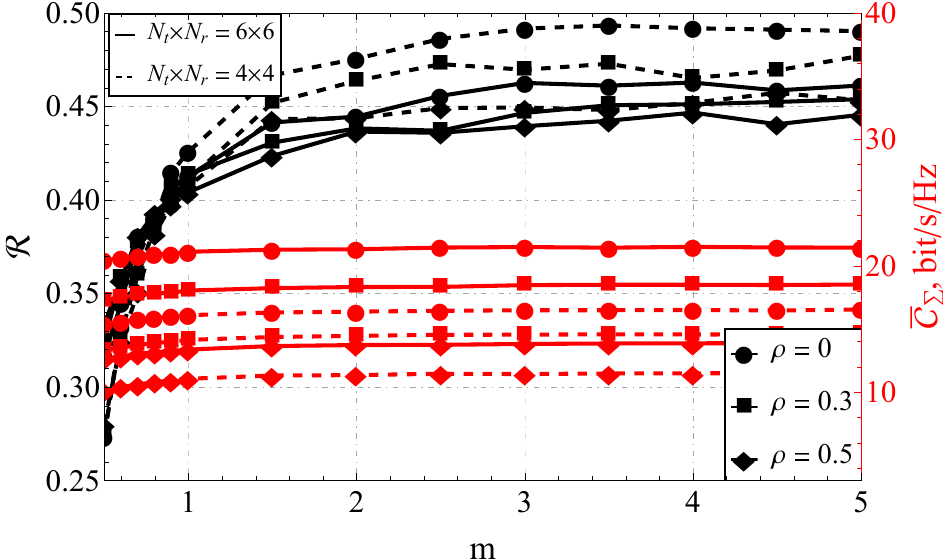
Figure 6. The joint R – C Σ performance of the 6 × 6 and 4 × 4 MIMO systems for various m ’s, γ = 20 dB, and different ρ ’s.